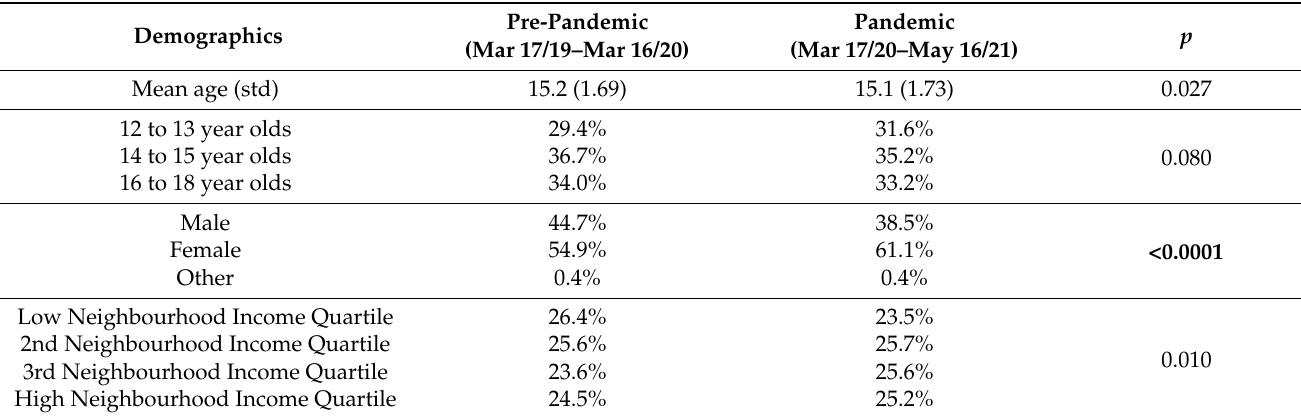
Table 1. Sample demographic description, by year.